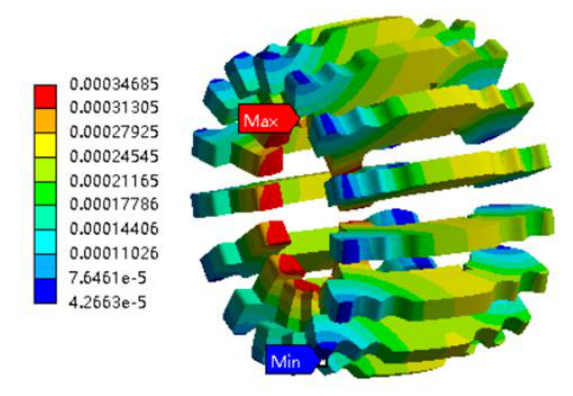
Fig. 11. Variation curve of the maximum temperature of plum contact with transient time under transient conditions